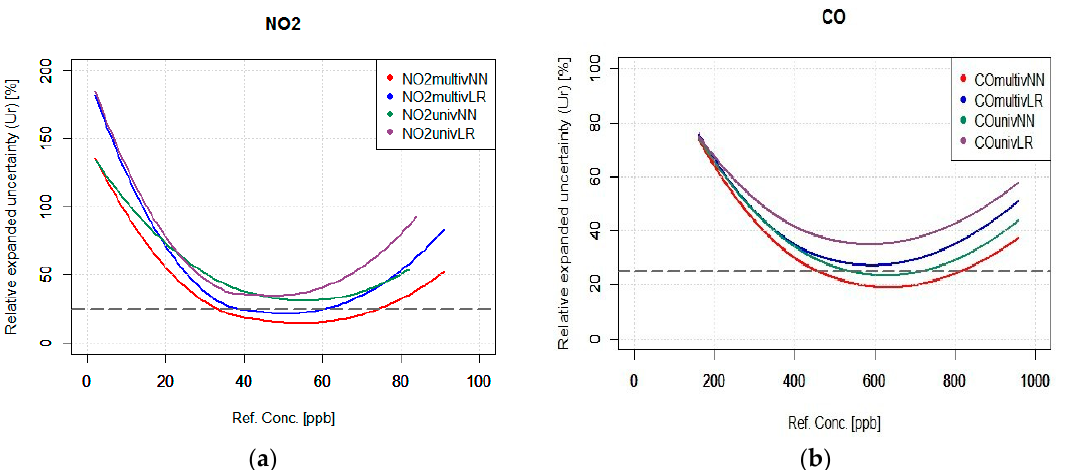
Figure 2. Relative expanded uncertainty computation for NO 2 and CO estimation after field calibration. For NO 2 (a), the use of multiple sensors output as calibration function was decisive to meet DQO threshold (dashed black line) indicating the need to compensate for interferents. On the contrary ( b ), non linear calibration schemes were the only to be capable to meet the DQO with a slight advantage of multivariate regression indicating a significant non linearity of the CO sensor response at the field recorded concentration